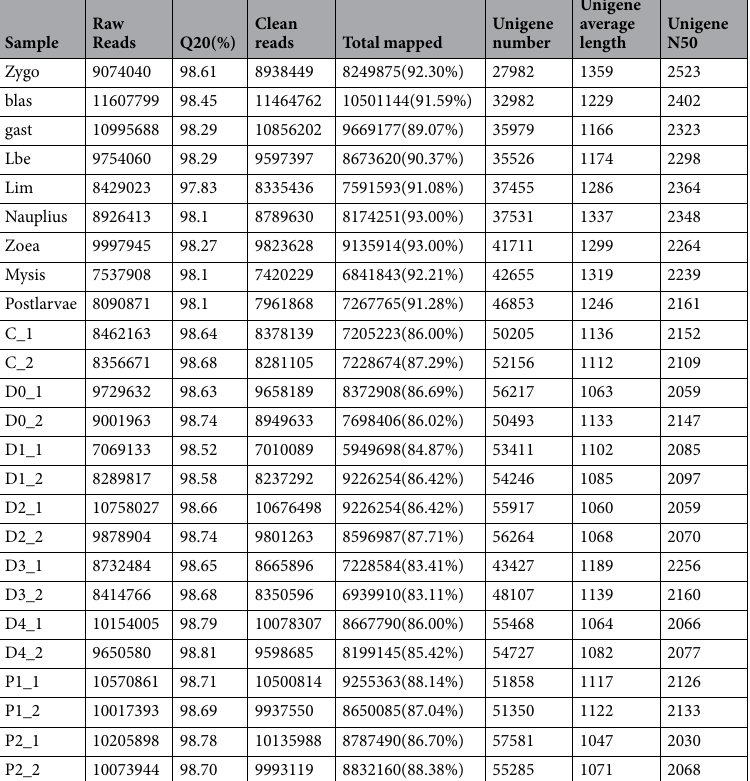
Table 3. Summary of sequencing and assembly of the